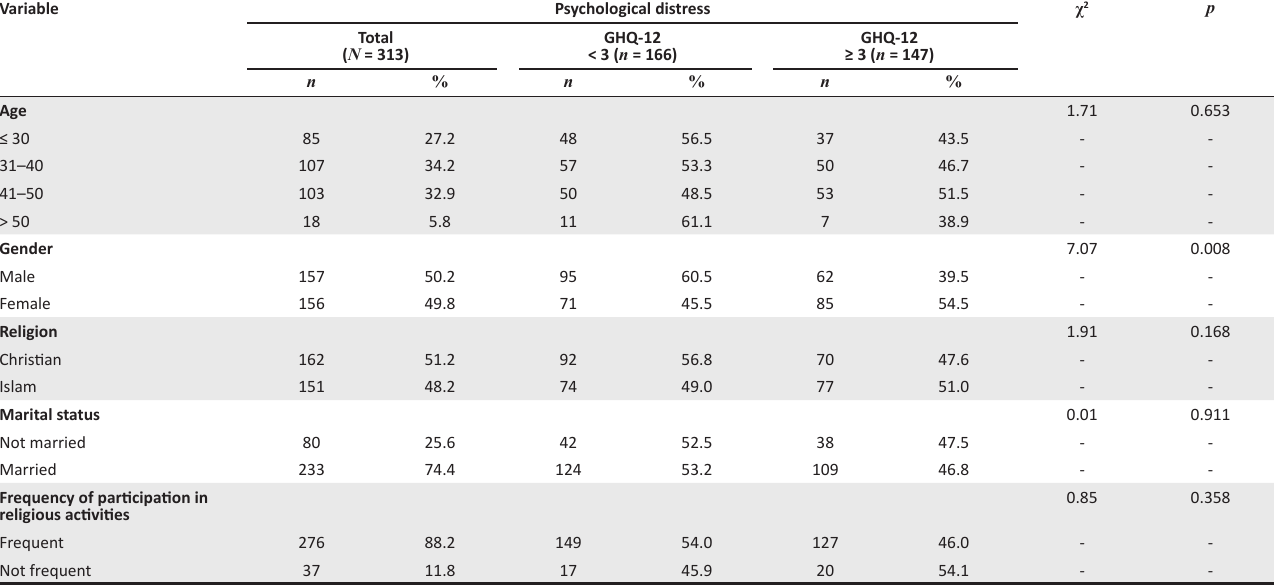
TABLE 1: Association between psychological distress and socio-demographic variables.